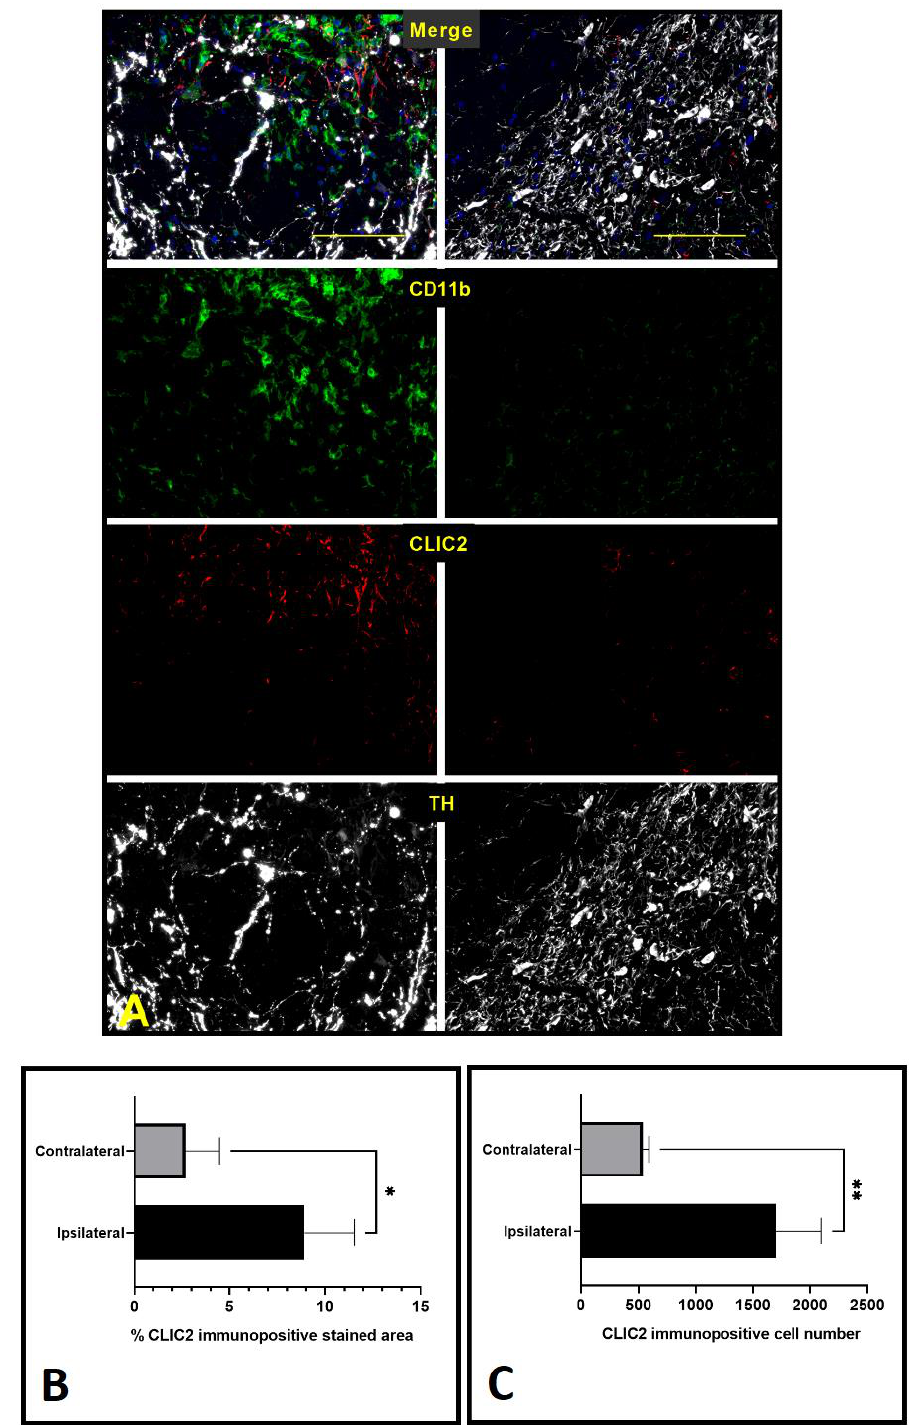
Figure 2. Colocalization of CLIC2 on microglia and dopaminergic neurons at the substantia nigra pars compacta of PD-modeled rat brain. Representative micrograph with Sale bar 100 μM where CLIC2 expressions on different cells were visualized with green color, neurons were marked with white color, and microglia were identified with red color ( A ), CLIC2 immunopositive stained area ( B ), CLIC2 immunopositive cell number ( C ). Data ( n = 3) were presented as mean ± SD and analyzed with unpaired two-tailed t -test. * p < 0.05 and ** p < 0.01 indicate significant difference between ipsilateral and contralateral